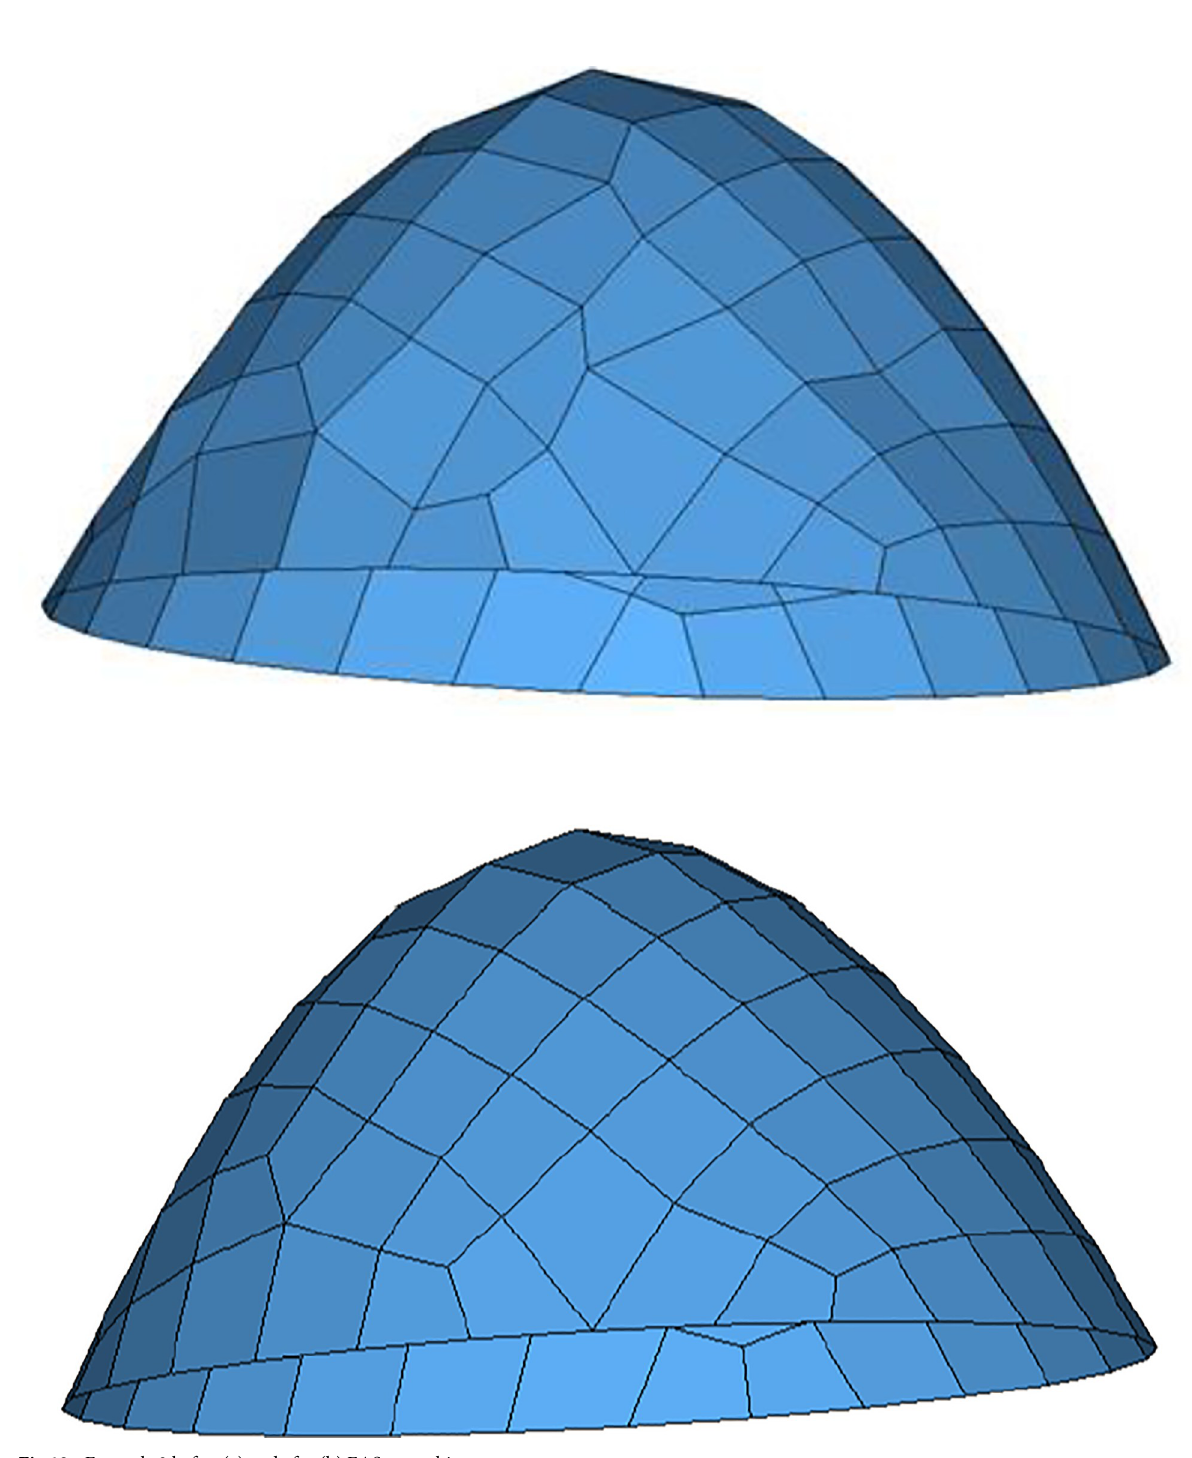
Fig 12. Example 2 before(a) and after(b) EAS smoothing.